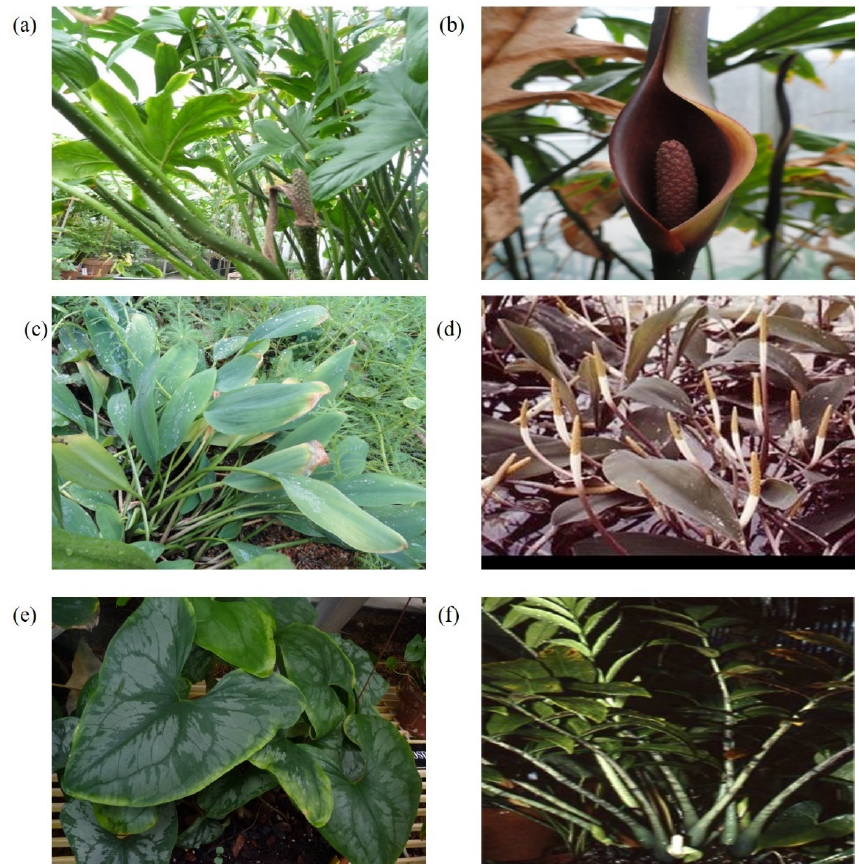
Figure 1. Vegetative and reproductive stages of bisexual and unisexual species. ( a ) L. spinosa , tropical Southeast Asian aculeate colony-forming evergreen herbs with deeply pinnatifid hastate-sagittate leaf blades and spadix at antithesis. ( b ) L. spinosa , solitary inflorescence of bisexual flowers. ( c ) O. aquaticum , temperate east North American seasonally dormant, aquatic herbs with oblong-elliptic blades held above water. ( d ) O. aquaticum , numerous bisexual inflorescences held above water level with disintegrated spathe not visible. ( e ) S. bogneri , tropical and southeast subtropical African evergreen herb with cordate-sagittate leaf blades. ( f ) Z. zamiifolia , tropical east to subtropical southeast African seasonally dormant or evergreen herb with pinnatisect leaf blades and an inflorescence of unisexual flowers with basal female and apical male flowers